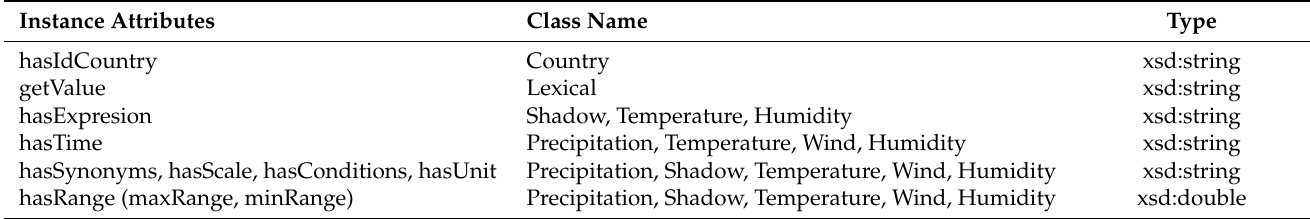
Table 7. Attributes for the hasSynonyms, hasScale, maxRange, minRange, hasUnit, hasExpresion